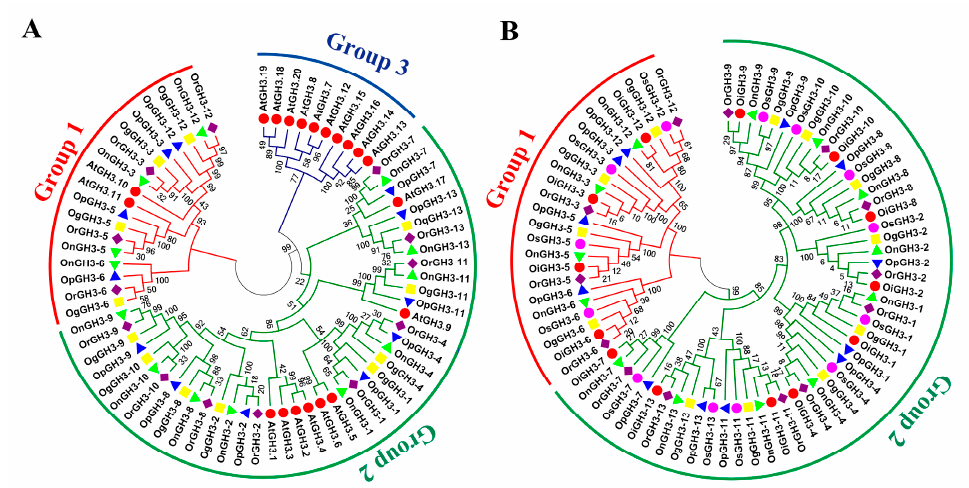
Figure 1. ( A ) A phylogenetic tree of GH3 protein sequences from five Oryza species and Arabidopsis . ( B ) A phylogenetic tree of GH3 protein sequences from six Oryza species/subspecies. Clustal W is used for multiple sequence alignment. MEGA 6.0 is adopted for phylogenetic reconstruction by using the Neighbor Joining (NJ) clustering method. Bootstrap numbers (1000 replicates) are shown. Different colors of circles represent different subfamilies. The different species are indicated by different shaped markers.